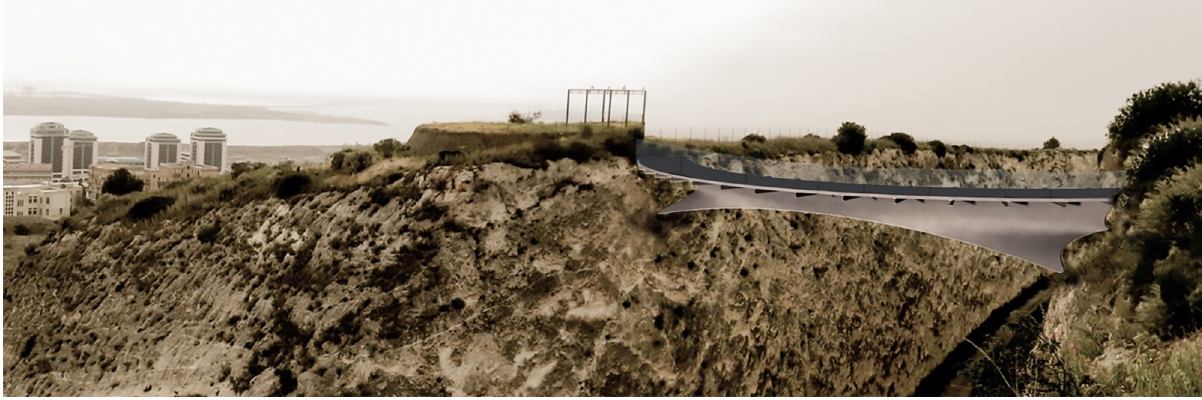
stiffness because, besides the boundary conditions, they can affect the shell